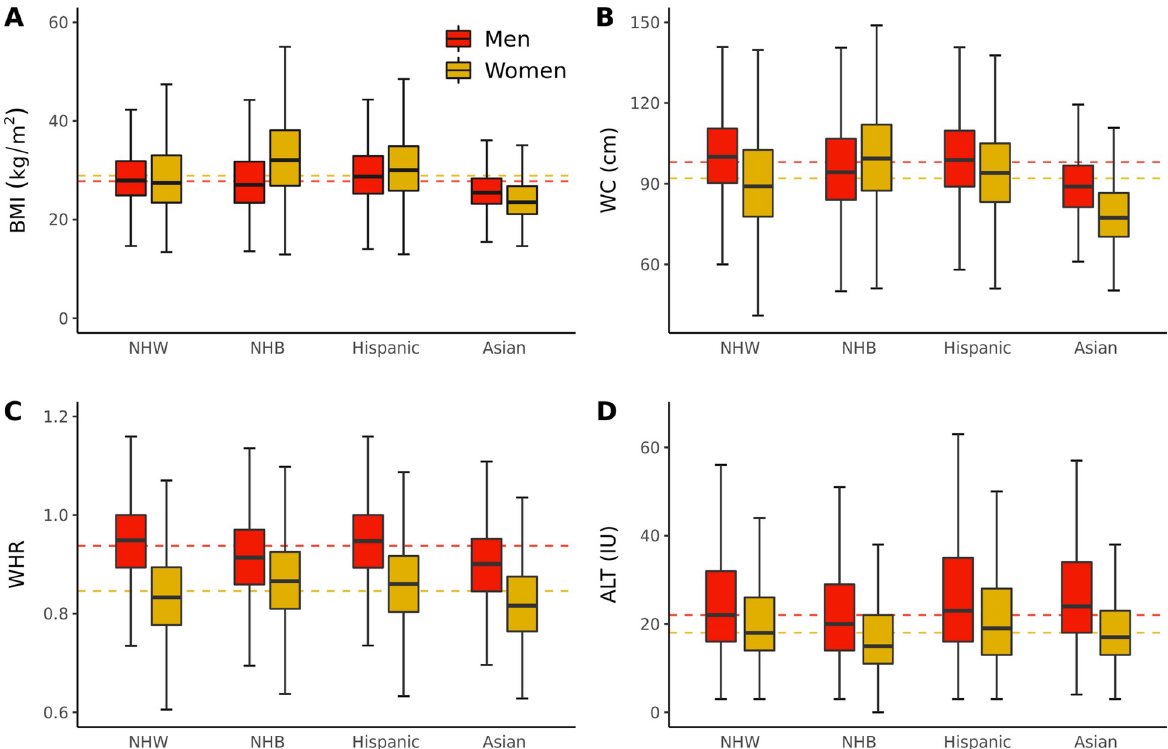
Fig 3. Anthropometric variables and ALT in all of us research program participants by gender and race/ethnicity. A) Body Mass Index (BMI), B) Waist Circumference (WC), C) Waist Hip Ratio (WHR), D) Alanine Aminotransferase (ALT). Horizontal dotted lines indicate the median body metric by gender. The boxplots visualize five summary statistics: Black lines indicate the median, lower and upper hinges reflect the 25th to 75th percentile, respectively, and the upper and lower error bars indicate the 5th and 95th percentiles, respectively. Due to privacy restrictions related to AoU publications policy, outlying observations are not plotted on boxplots. Men and women were included if they self-reported a single race/ethnic group in Asian, Black or African American, Hispanic or Latino, or White. NHB indicates Non-Hispanic Black and NHW, Non-Hispanic White.